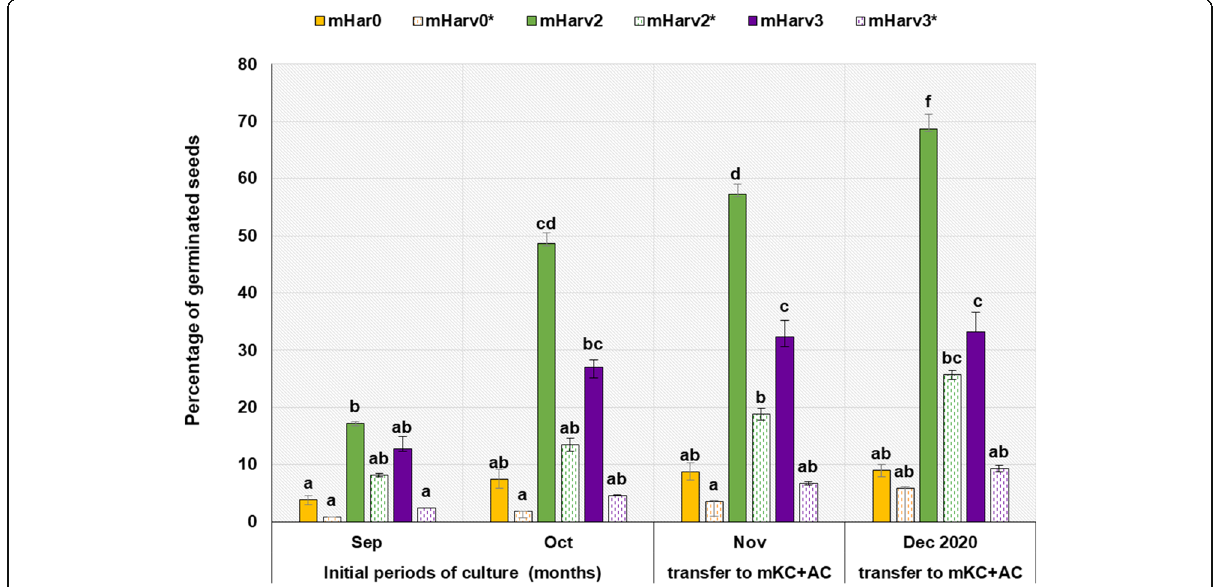
Fig. 2 Comparative effects of plant growth regulators and photoperiod on the germination of immature seeds of Orchis militaris during 5 months of cultivation. # * mark is the indication of the 16/8 h L/D photoperiod conditions, in which seed cultivation on these media was performed, in contrast to the dark conditions (0/24 h L/D), applied with the media without this mark; the means having the same superscript letters in a column were not significantly different as determined by Duncan ’ s multiple range test ( p <